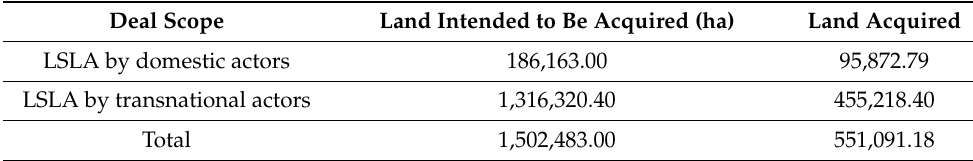
Table 1. Large-Scale Land Acquisition in Ghana. Deal Scope Land Intended to Be Acquired (ha) Land Acquired LSLA by domestic